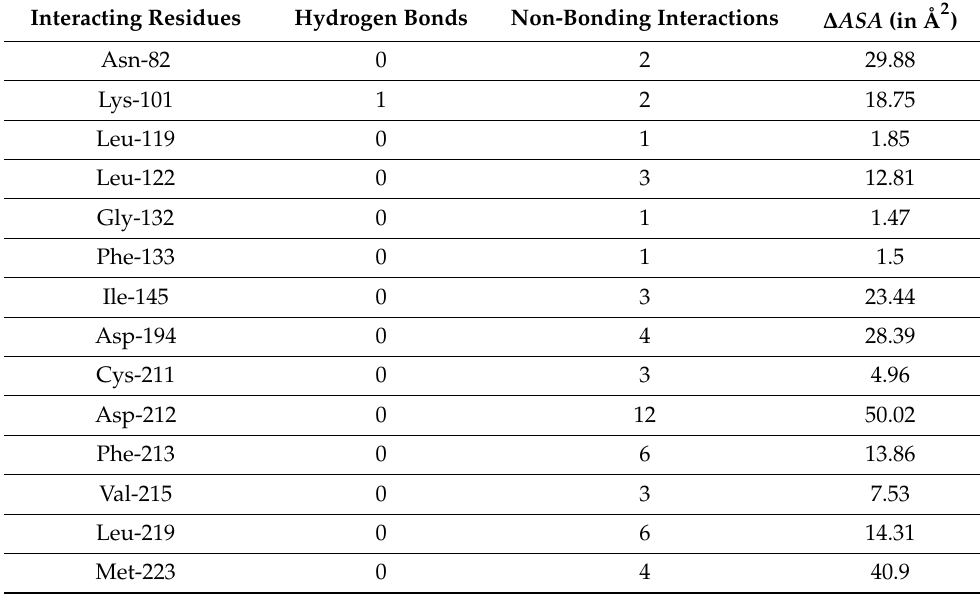
Table A9. The MEK2 residues interacting with selected flavonoid M2F9 are listed with the number of non-bonding interactions and ∆ ASA